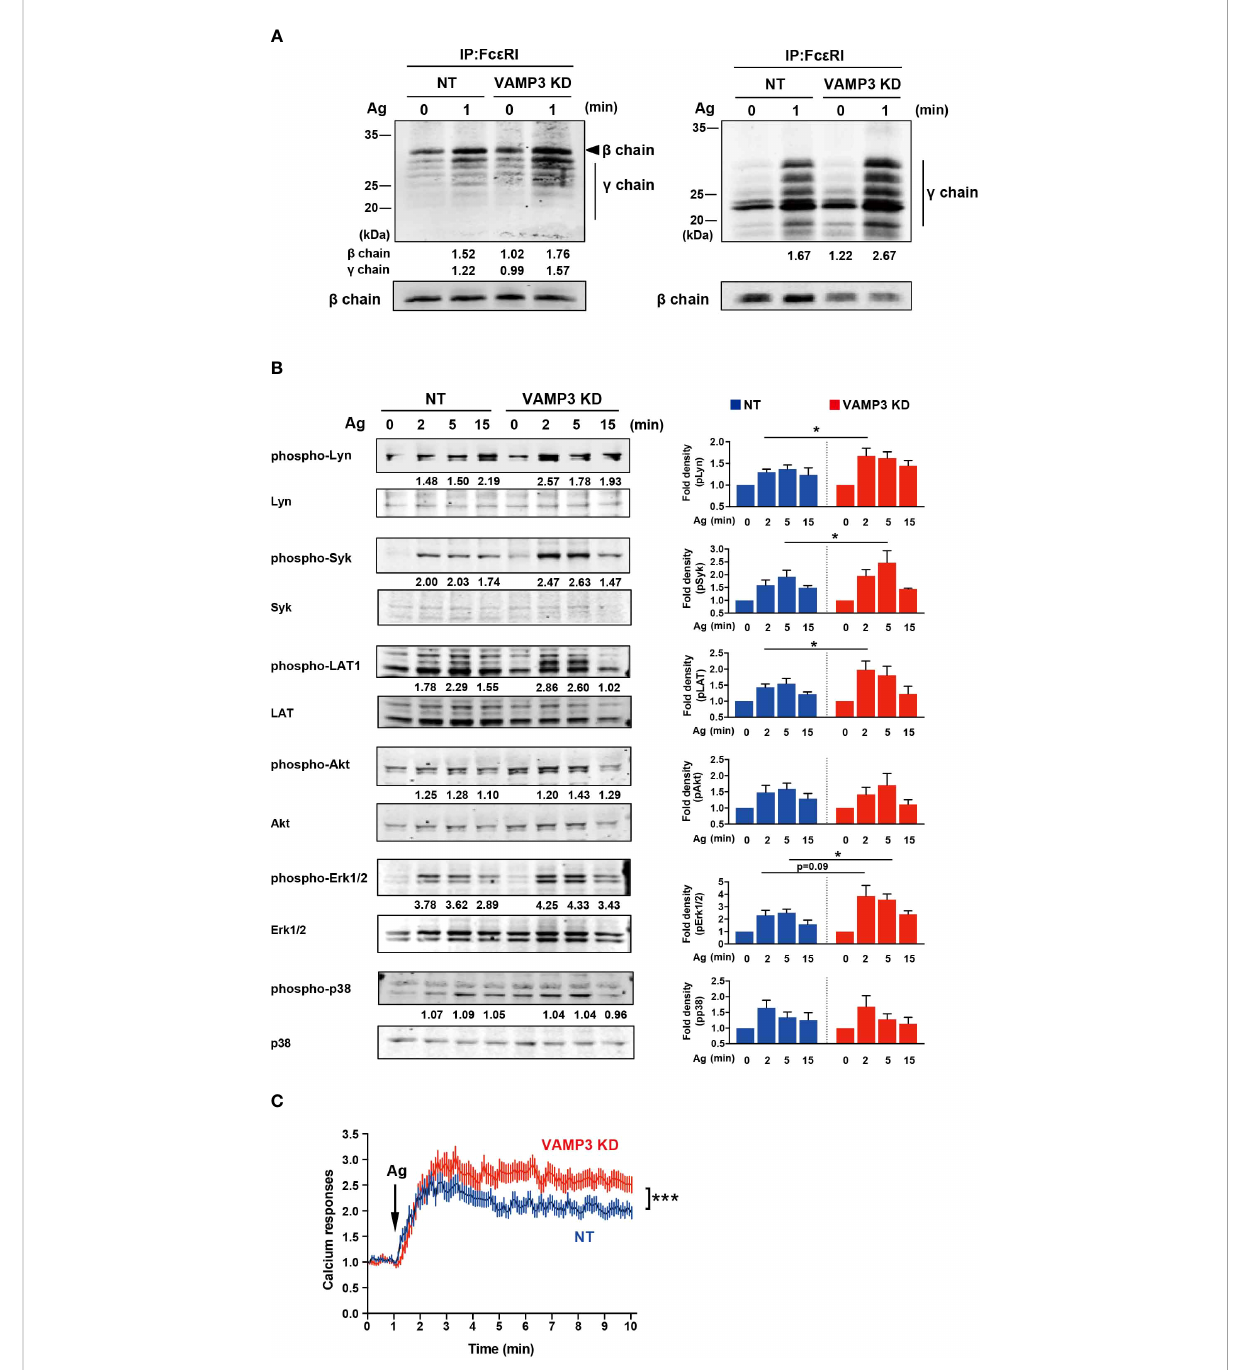
FIGURE 3 Fc ϵ RI phosphorylation is upregulated following Ag stimulation Fc ϵ RI signaling following Ag stimulation (50 ng/ml) was analyzed, which resulted in enhanced VAMP3 KD. (A) Fc ϵ RI was precipitated and analyzed by immunoblotting with antibodies speci fi c for tyrosine-phosphorylated proteins (4G10, left panel) and phosphorylated ITAMs of Fc ϵ RI g (right panel). Expression of b -chain was measured as an internal loading control by re-blotting the membranes with anti- b chain antibody JRK. (B) A series of protein phosphorylation events triggered by Fc ϵ RI crosslinking with the Ag was analyzed. (C) Calcium response. Each line represents the mean ± standard error of 51-69 single cells/group from 4 independent experiments. One representative blot of three independent experiments is shown. The band density normalized to that of unstimulated cells is shown below each band (A, B) . The P values refer to the differences between two groups that were analyzed using the two-tailed Student ’ s t-test. NT: control knockdown with a non-targeting shRNA plasmid. Ag: antigen. *p<0.05,